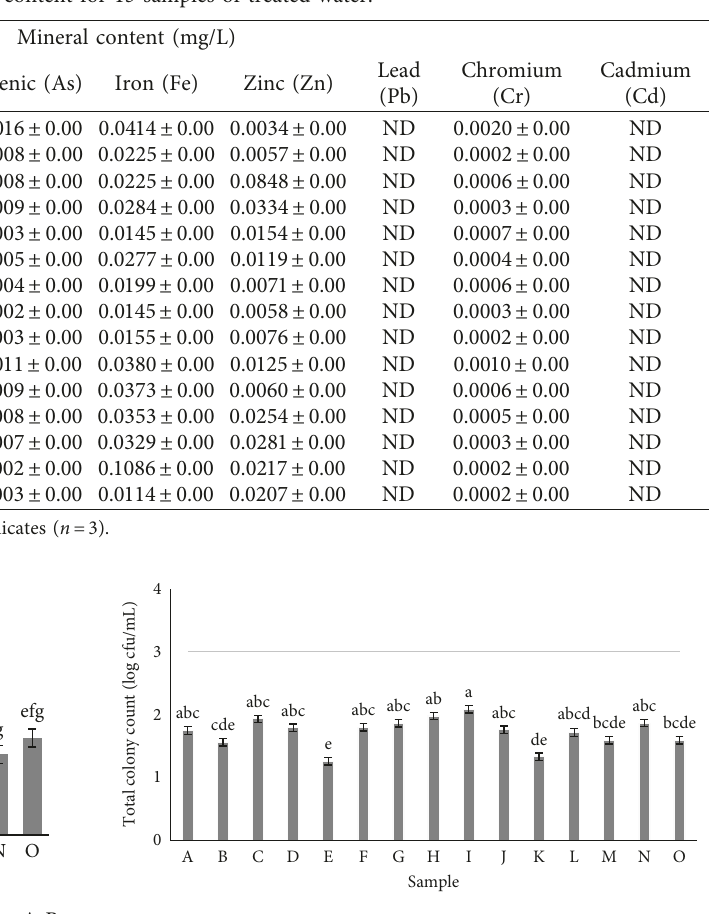
Table 2: The mineral content for 15 samples of treated water.